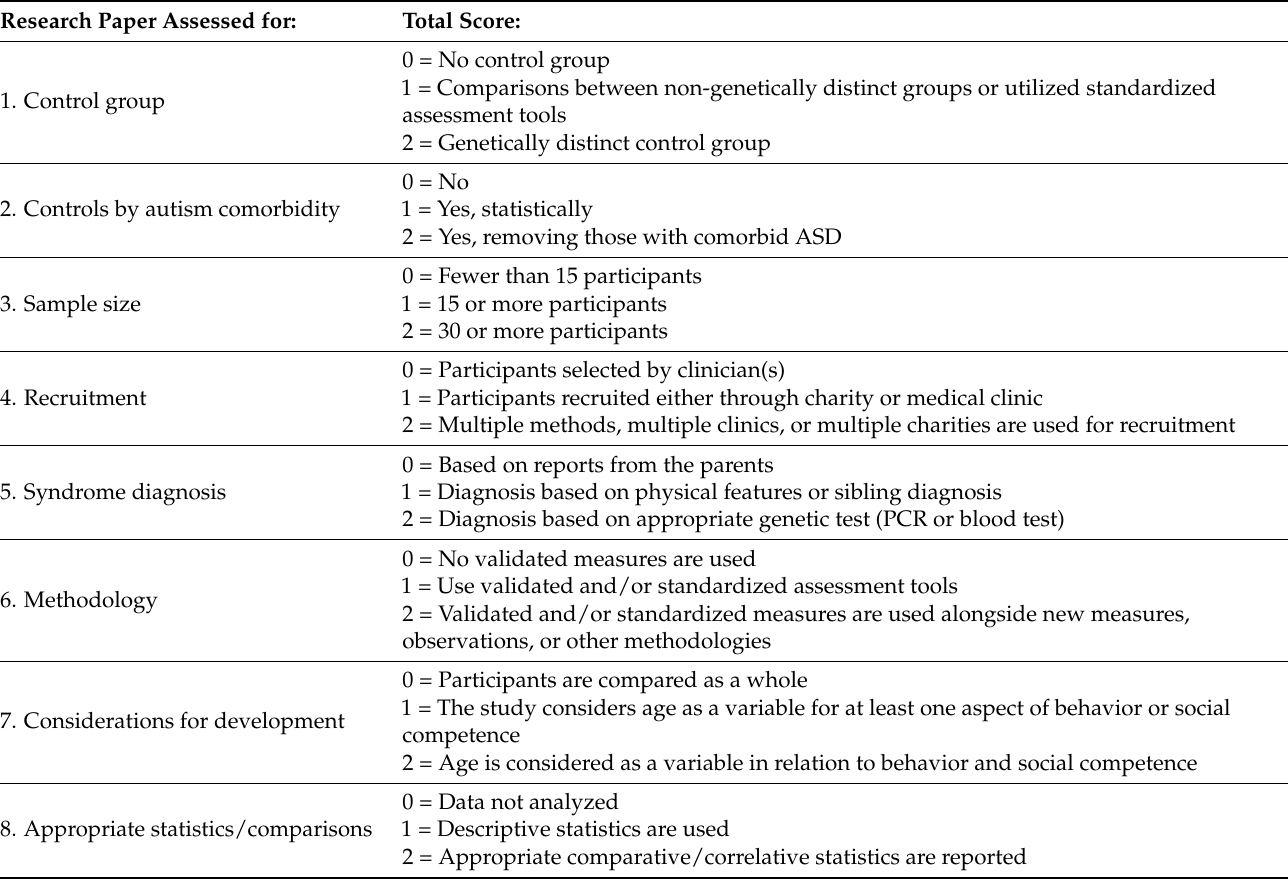
Table A1. Matrix for assessing quality of